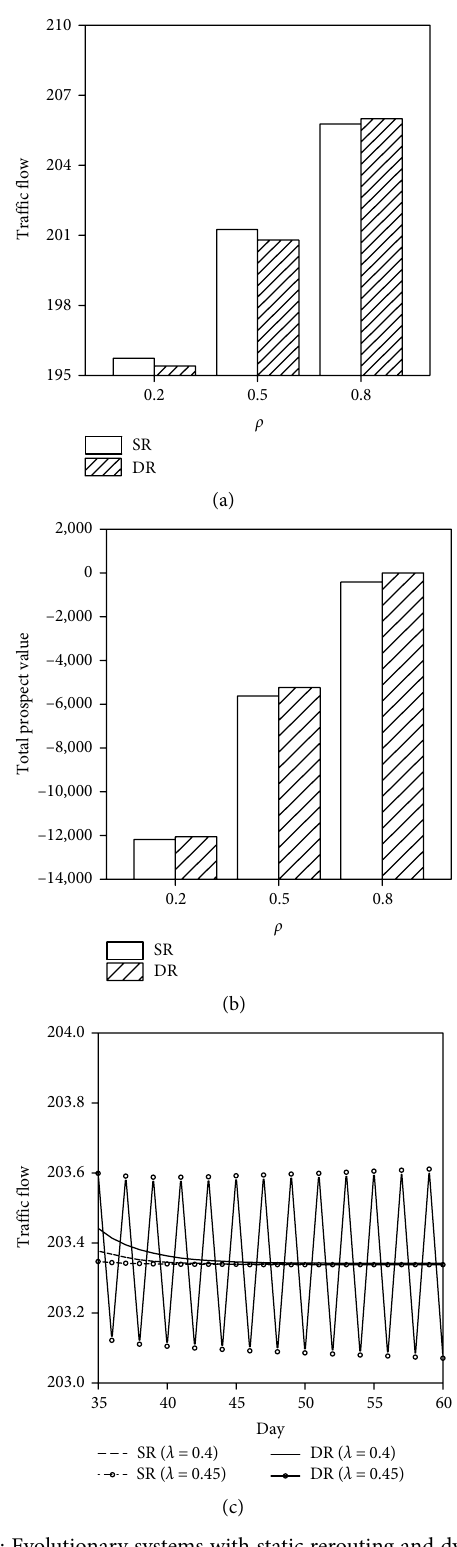
Figure 6: Evolutionary systems with static rerouting and dynamic rerouting behavior. (a) Equilibrium state. (b) System efficiency. (c) Sensitivity to parameter λ